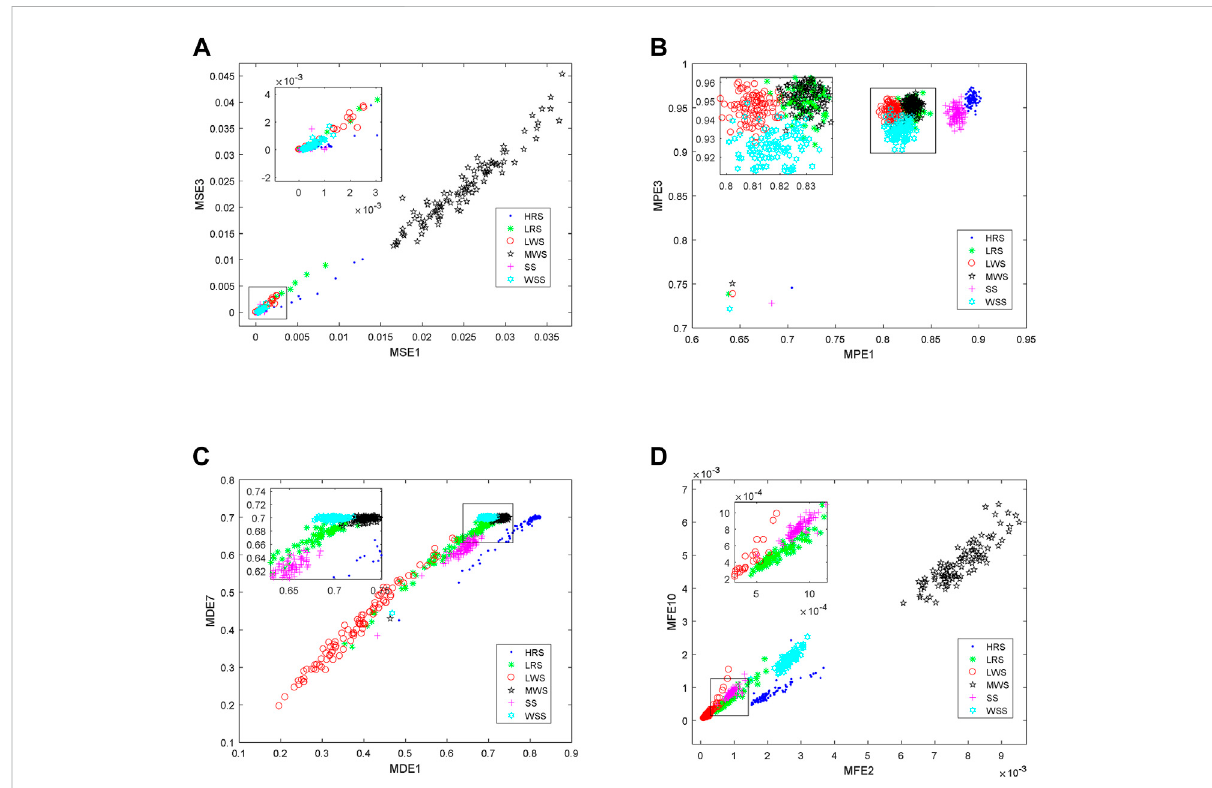
FIGURE 5 Multi-feature distribution results correspond to the highest ARR for six ANs. (A) is MSE, (B) is MPE, (C) is MDE, (D) is MFE.